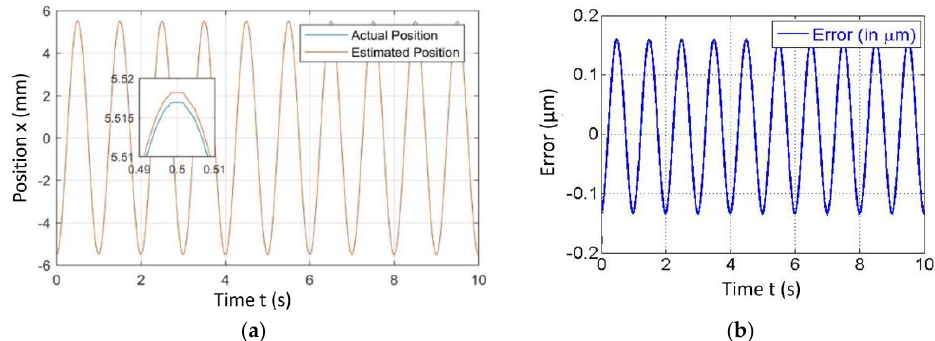
Figure 5. Simulated results of the position estimator algorithm at 1 Hz frequency for ( a ) Position comparison and ( b ) Error between actual and estimated position.